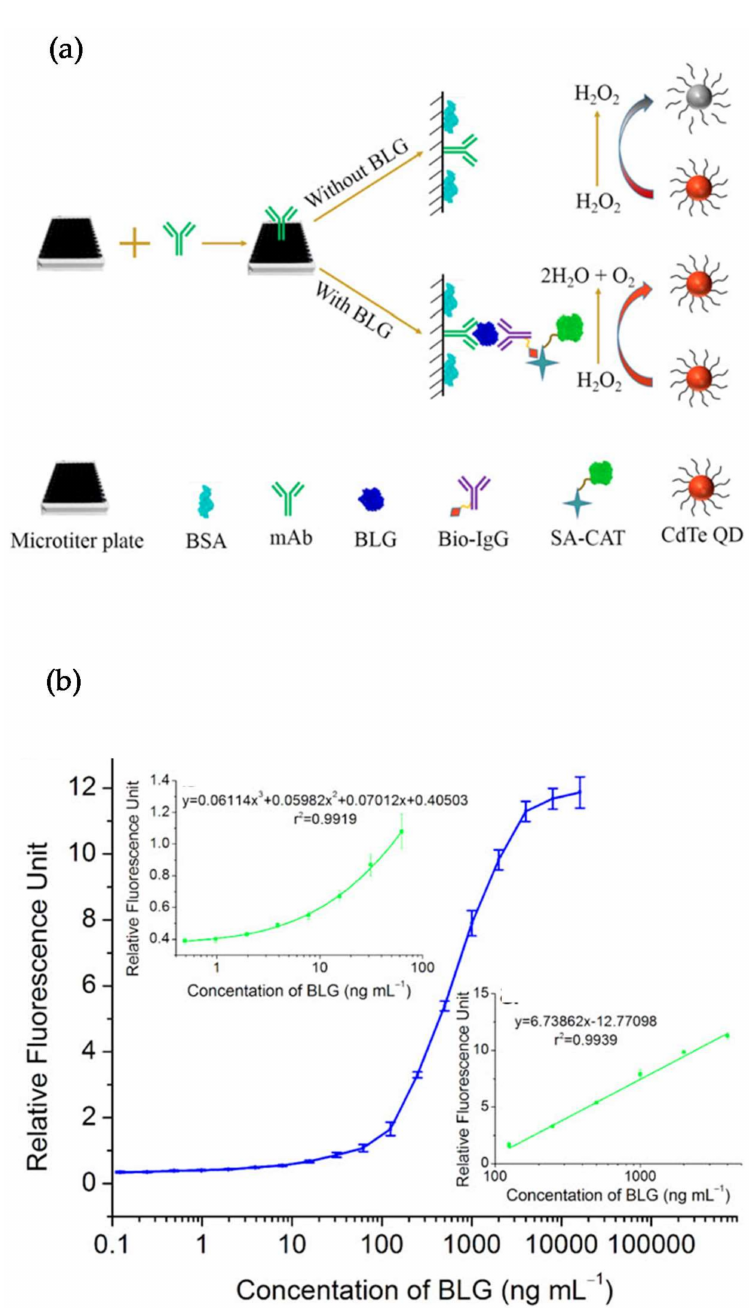
Figure 6. ( a ) Schematic principle of the immunoassay based on catalase-mediated fluorescence quenching of H 2 O 2 -sensitive quantum dots (QDs) for the detection of β -La; ( b ) Calibration curve of fluorescent ELISA for detection of β -La. Reprinted with permission from [102]. Copyright 2018